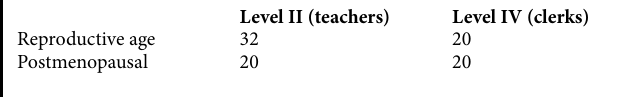
Table I. Distribution of subjects into